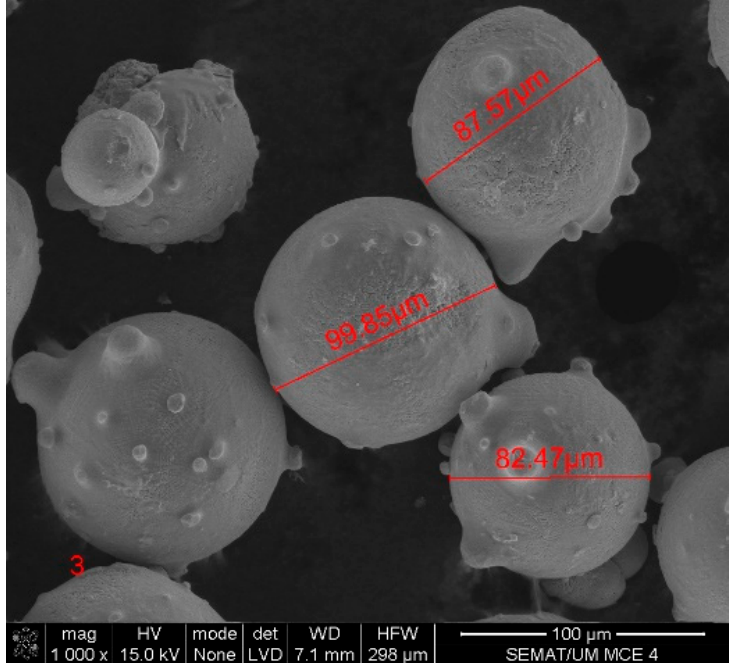
Figure 8. SEM analysis results: Sample collected during Trial 1 with the cobalt–chromium–silicon– carbon alloy.